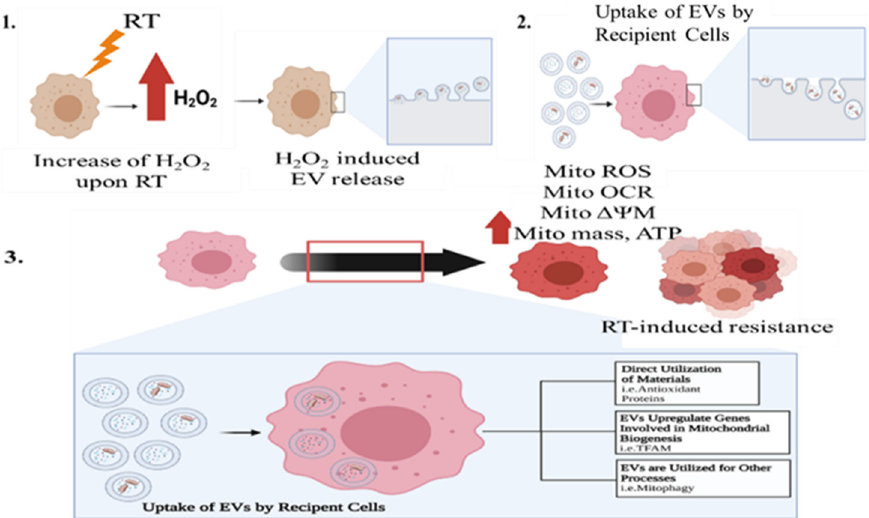
Figure 9. Proposed mechanism of how RT–derived H 2 O 2 ( 1 ) Reprogram mitochondrial homeostasis in the recipient cells through EVs containing mitochondria ( 2 ), which allows the cancer to survive and regrow after RT ( 3 ).